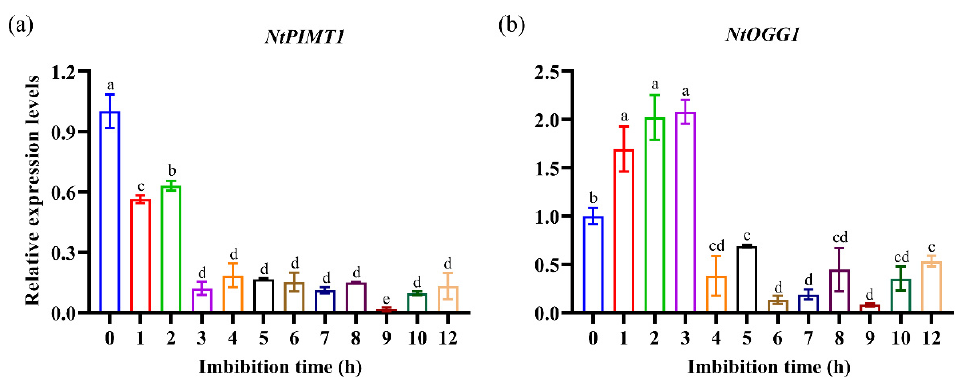
Figure 2. Characteristics of NtPIMT1 and NtOGG1 expression during seed germination in unaged and non-pelleted seeds of tobacco cultivar ‘Yunyan 87 ′ . Expression patterns of ( a ) NtIPMS1 and ( b ) NtOGG1 during early seed germination in 25 °C conditions. Data are means (±SD), n = 3. Different letters above the column indicate significant differences determined using ANOVA test: p < 0.01.